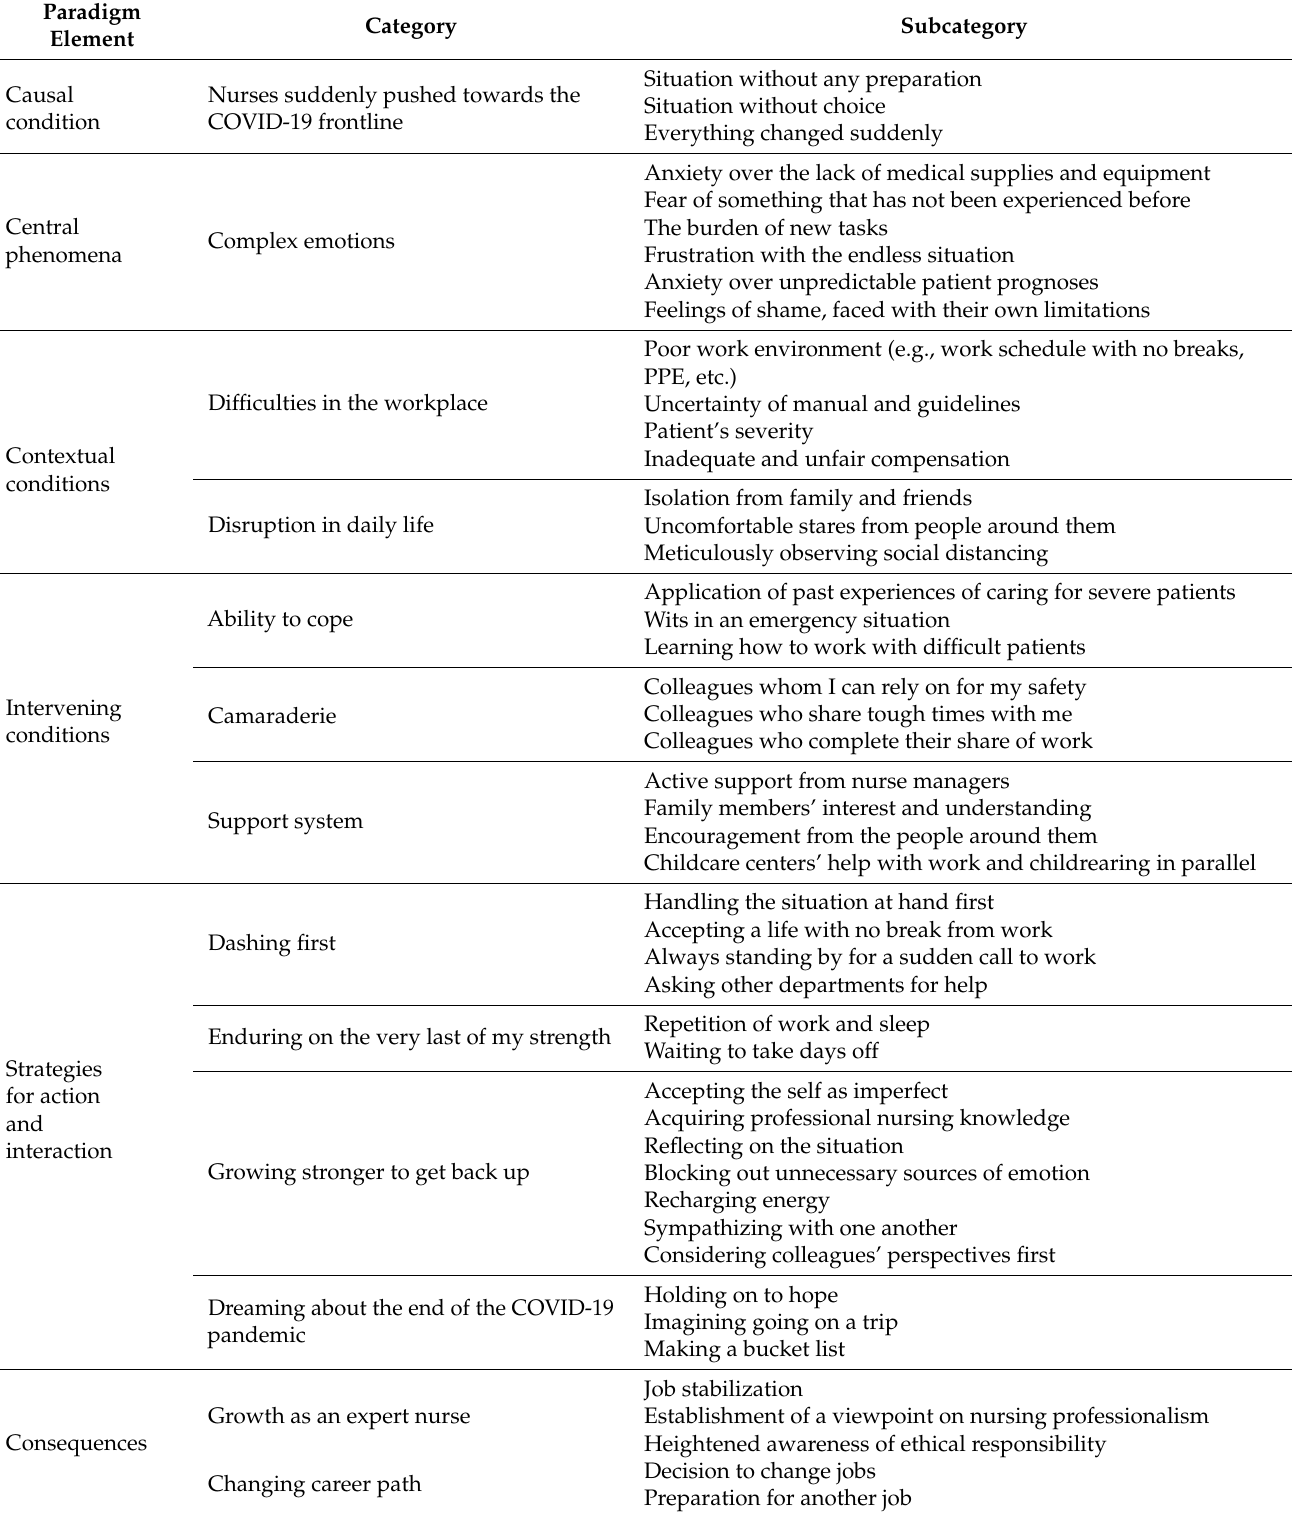
Table 1. Paradigm, categories, and subcategories of nurses’ adaptation processes in caring for COVID-19